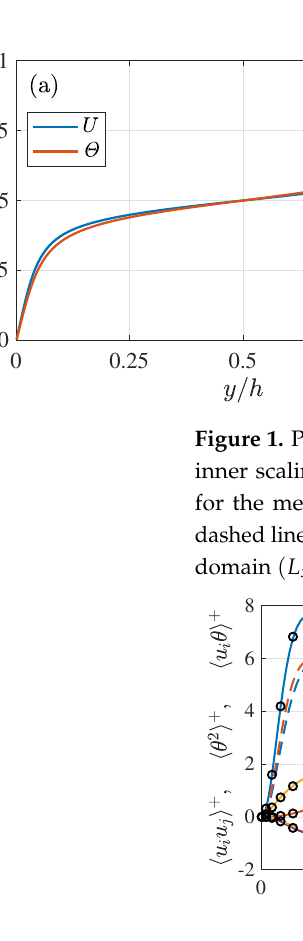
(cid:68) (cid:69) u i u j Figure 2. Profiles of (solid lines) the Reynolds stresses and (dashed lines) the temperature- (cid:10) (cid:11) θ 2 related turbulent statistics and (cid:104) u i θ (cid:105) . The values are scaled based on the inner units, u τ and/or T τ , and only 0 (cid:28) y (cid:28) 0.5 is shown. The black circles present profiles of the Reynolds stresses obtained with an extremely large computational domain ( L x , L z ) = ( 96 h ,12.8 h ) in Ref.